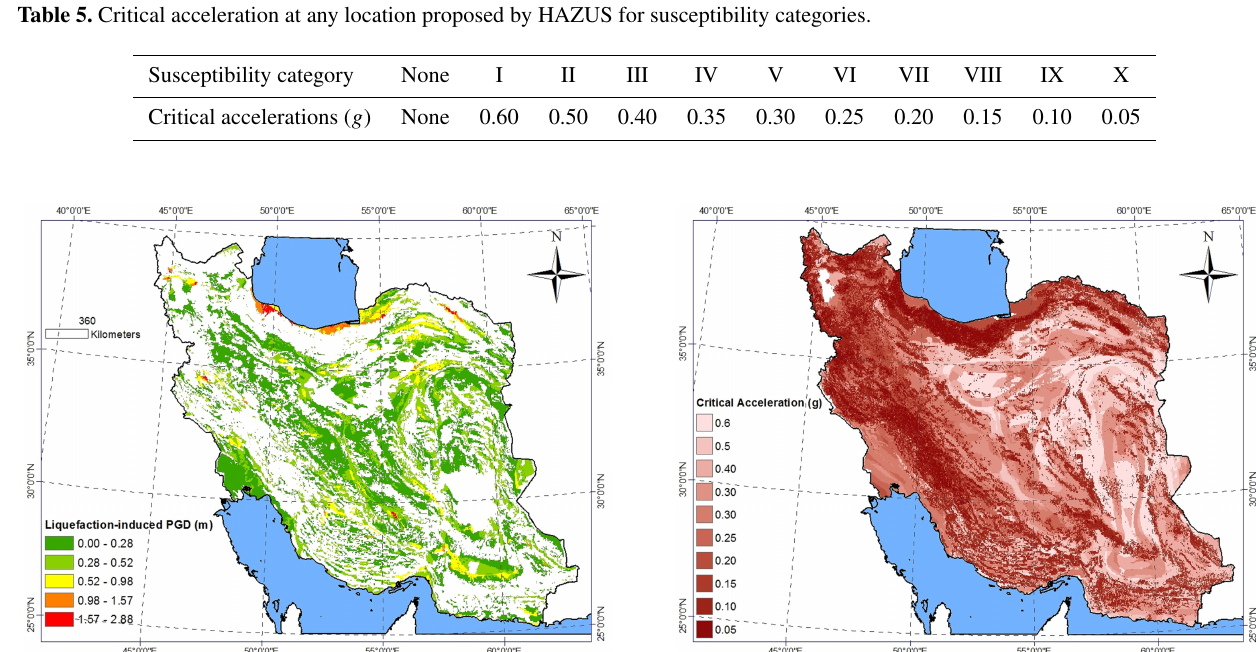
Table 5. Critical acceleration at any location proposed by HAZUS for susceptibility categories.